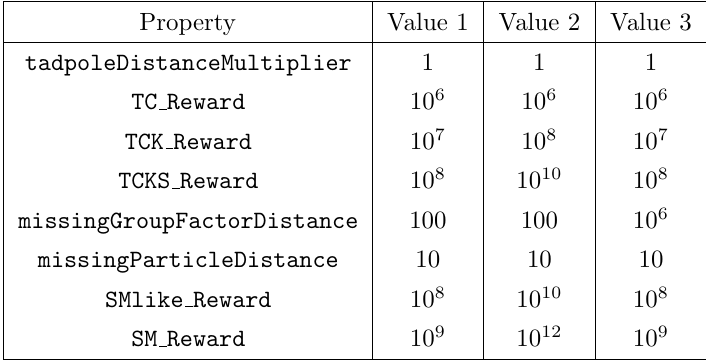
Table 2 . Value assignments for the SIMULT reward function.